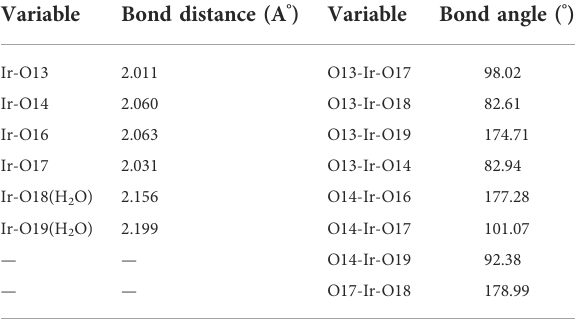
TABLE 5 Optimized geometrical variables of the complex [Ir (III)- CHMTB]. Variable